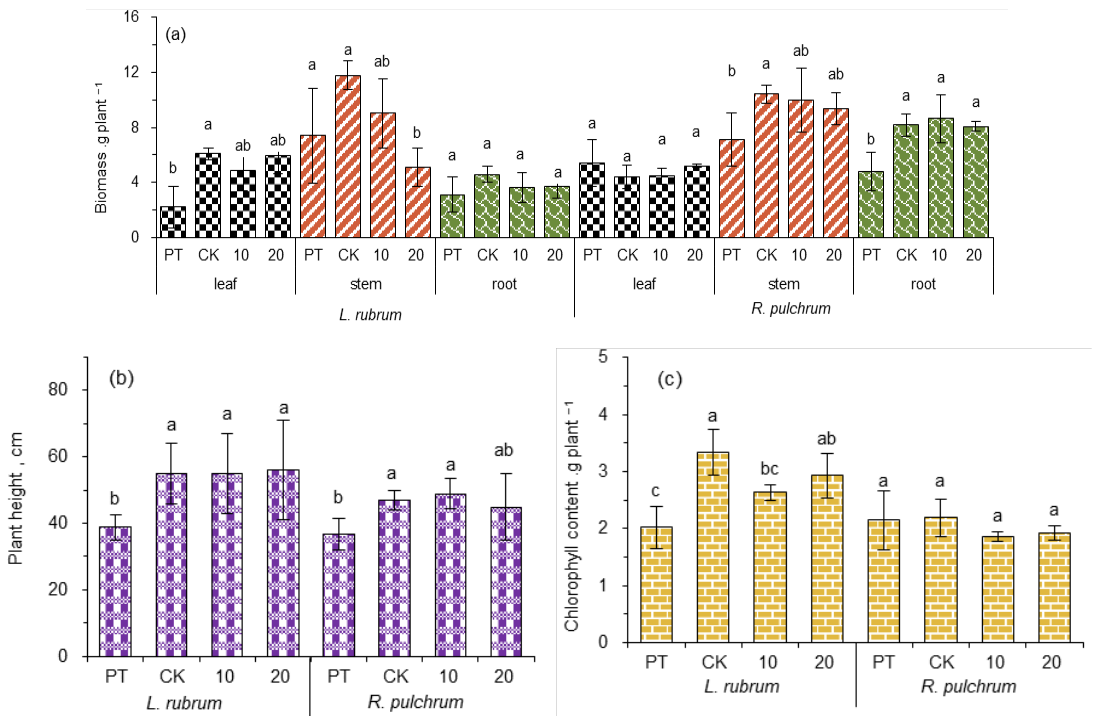
Figure 2. Influence of exogenous IAA treatment on ( a ) biomass, ( b ) plant height, and ( c ) chlorophyll content of L. rubrum and R. pulchrum . Different letters in the same column of the same plant indicate significant differences among the treatments, p < 0.05. The posthoc test was performed with Tamhane method. PT indicates samples of pre-treatment, while CK, 10, and 20 are IAA treatments at 0, 10, and 20 mg L −1 , respectively.